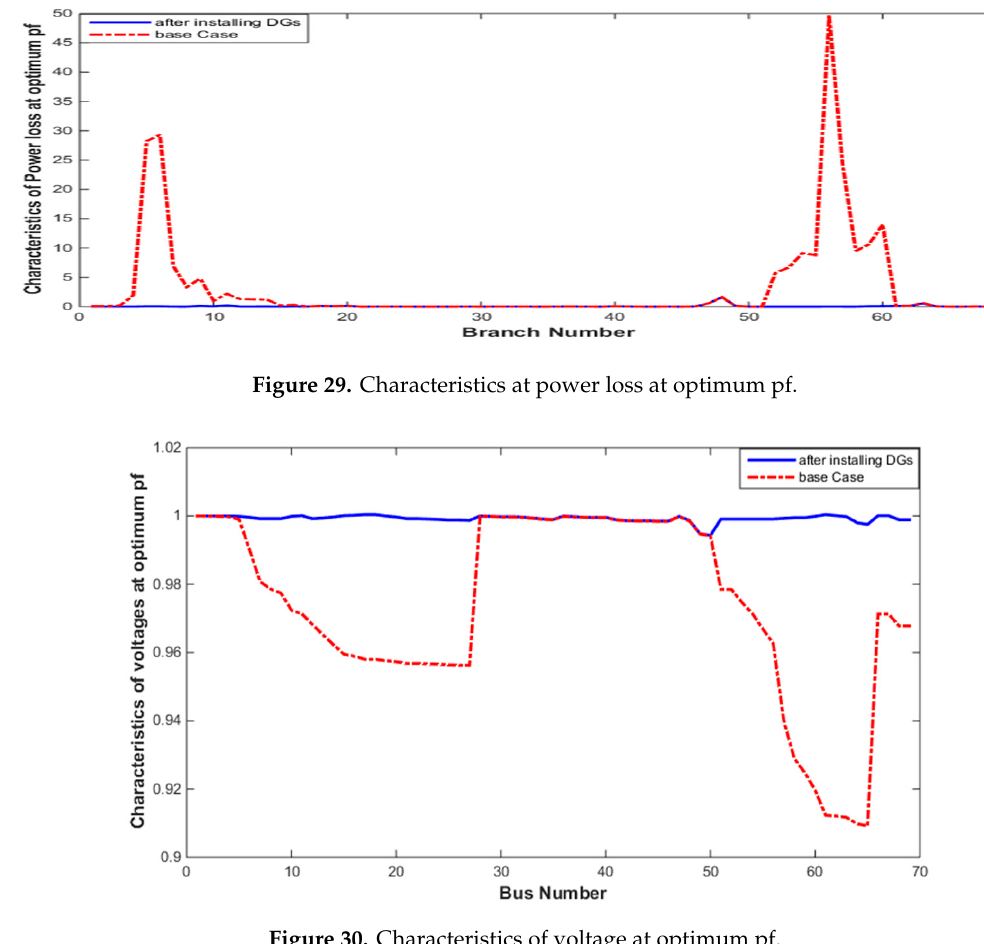
Figure 31. Characteristics of VSI at optimum pf. The final sub-case in the IEEE 69-bus system is optimizing the size and location of three DG units operating at an optimum power factor. The results obtained by MRFO and three other techniques are listed in Table 9. The best locations determined using MRFO are 17, 11, and 61 which are completely different from the results of other techniques. The maximum power loss is minimized to 4.2775 kW with a total reduction of 98.0984% which is the best-obtained value. The voltage deviation also provided by the MRFO algorithm is the minimum value of 0.0001. Finally, the voltage stability index obtained by the MRFO algorithm is almost the same as the results obtained by SFSA. MRFO and SFSA techniques provide the best results compared to others. The MRFO algorithm takes a smaller number of iterations, namely 50, to achieve the optimum solution, unlike SFSA that takes double the number of iterations, 100. That gives superiority to the MRFO algorithm.